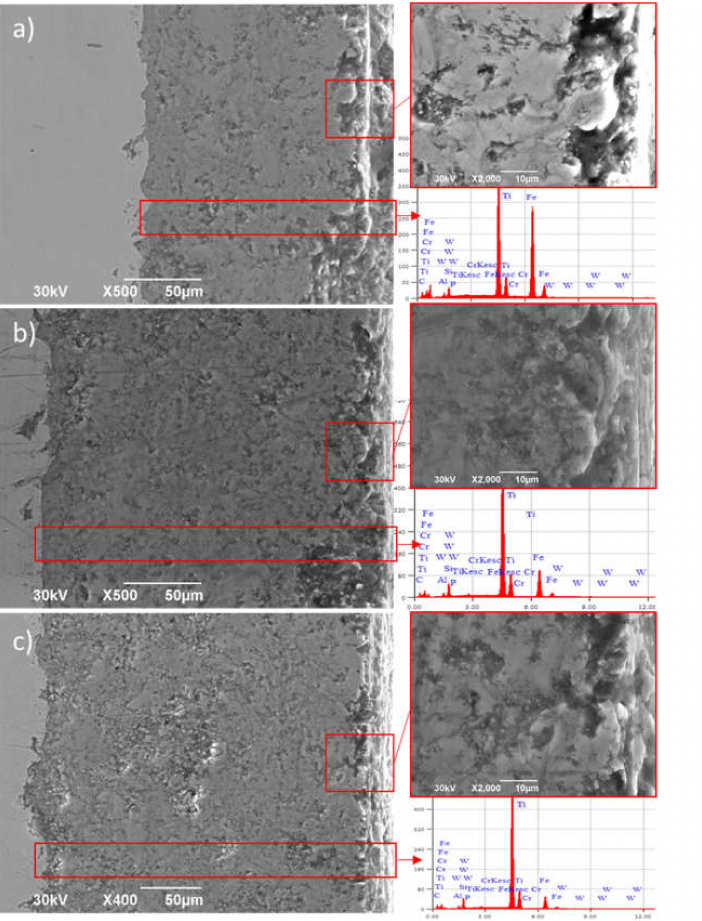
Figure 5. SEM images of the morphology of the cross-section of the Ti–Si–C coating after pulsed- plasma treatment depending on the distance from the plasmatron: ( a ) 30 mm, ( b ) 40 mm, ( c ) 50